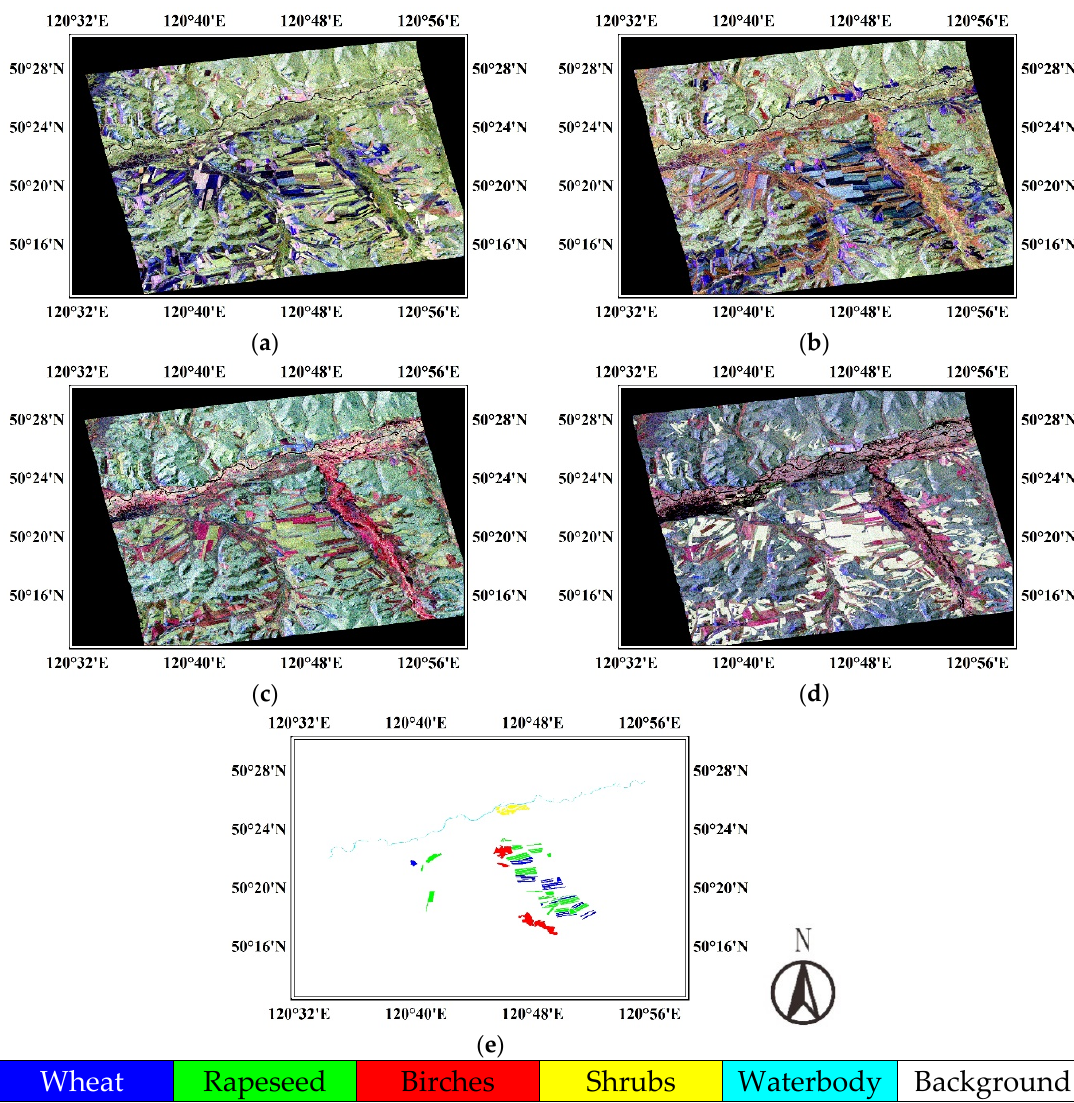
Figure 8. PauliRGB images of multi-temporal Radarsat-2 dataset and ground truth map in 2012. ( a ) Domain A (2012-09-01); ( b ) Domain B (2013-06-16); ( c ) Domain C (2013-07-10); ( d ) Domain D (2013-08-03); ( e ) Ground truth map of Domain A .